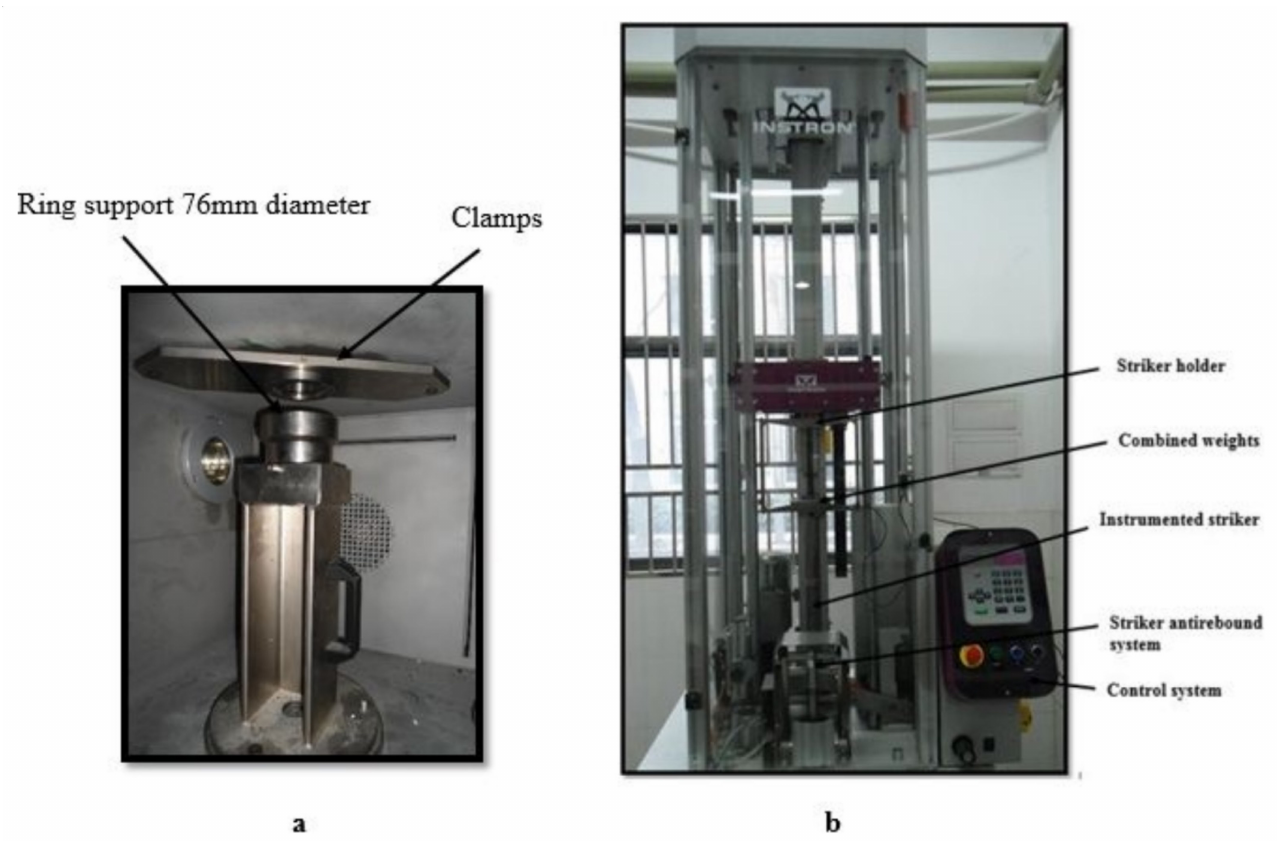
Figure 3. CEAST 9350 impact tester ( a ) test chamber and ( b ) device